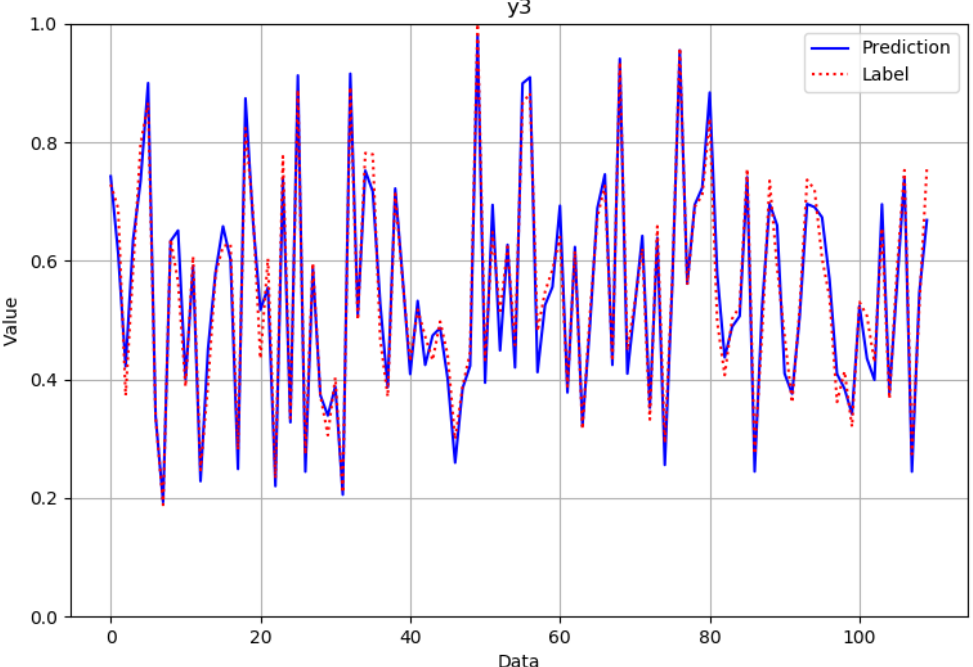
Figure 14. Comparison of predicted and actual values in the elongation at break verification data set after normalization.